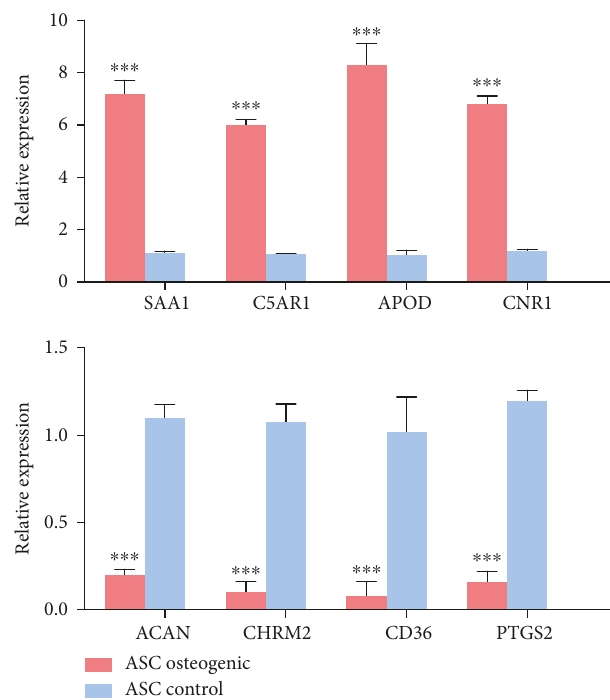
Figure 5: qPCR validation of the RNA-seq data. Consistent with our RNA-seq data, the expression levels of SAA1, C5AR1, APOD, and CNR1 were signi fi cantly upregulated in osteogenic di ff erentiated ASCs, while the levels of ACAN, CHRM2, CD36, and CHRM2 were remarkably